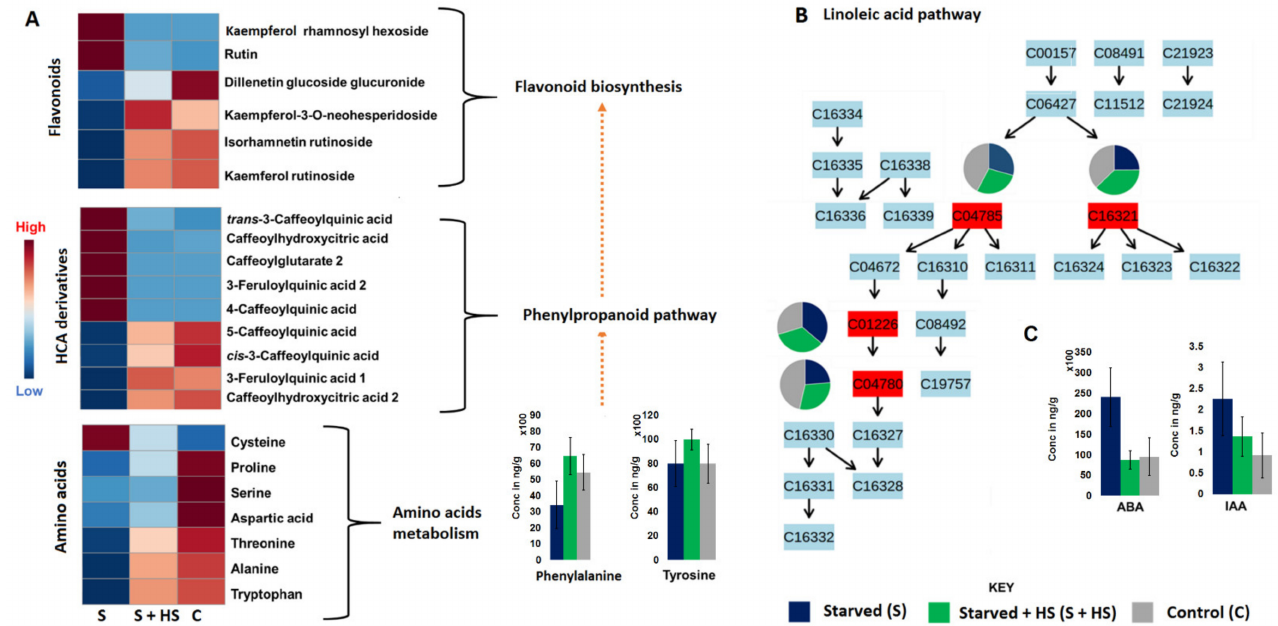
Figure 3. Relative quantification and pathway mapping of annotated metabolites under nutrient starvation. ( A ) Heatmaps and bar graphs showing the relative (and absolute) quantification of amino acids, HCA derivatives and flavonoids. ( B ) Pathway mapping of annotated oxylipins and their differential distribution in control, HS-treated and untreated under nutrient starvation. ( C ) Bar graphs showing the absolute quantification of some hormones, ABA and IAA; p -values are reported in Table